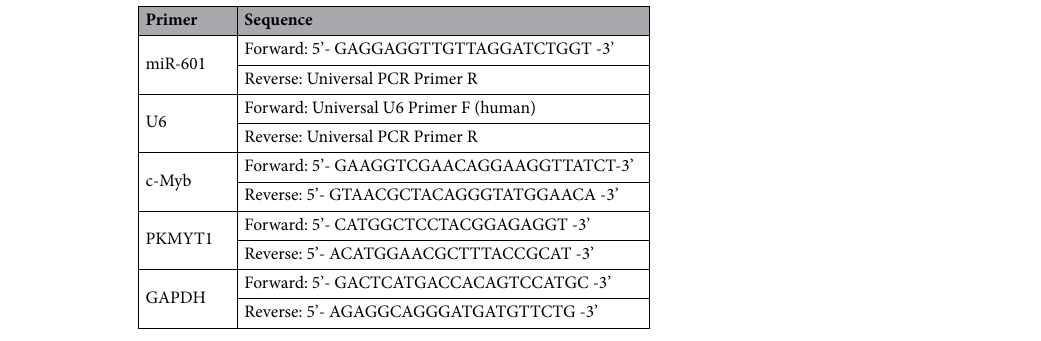
Table 2. The sequence of PCR